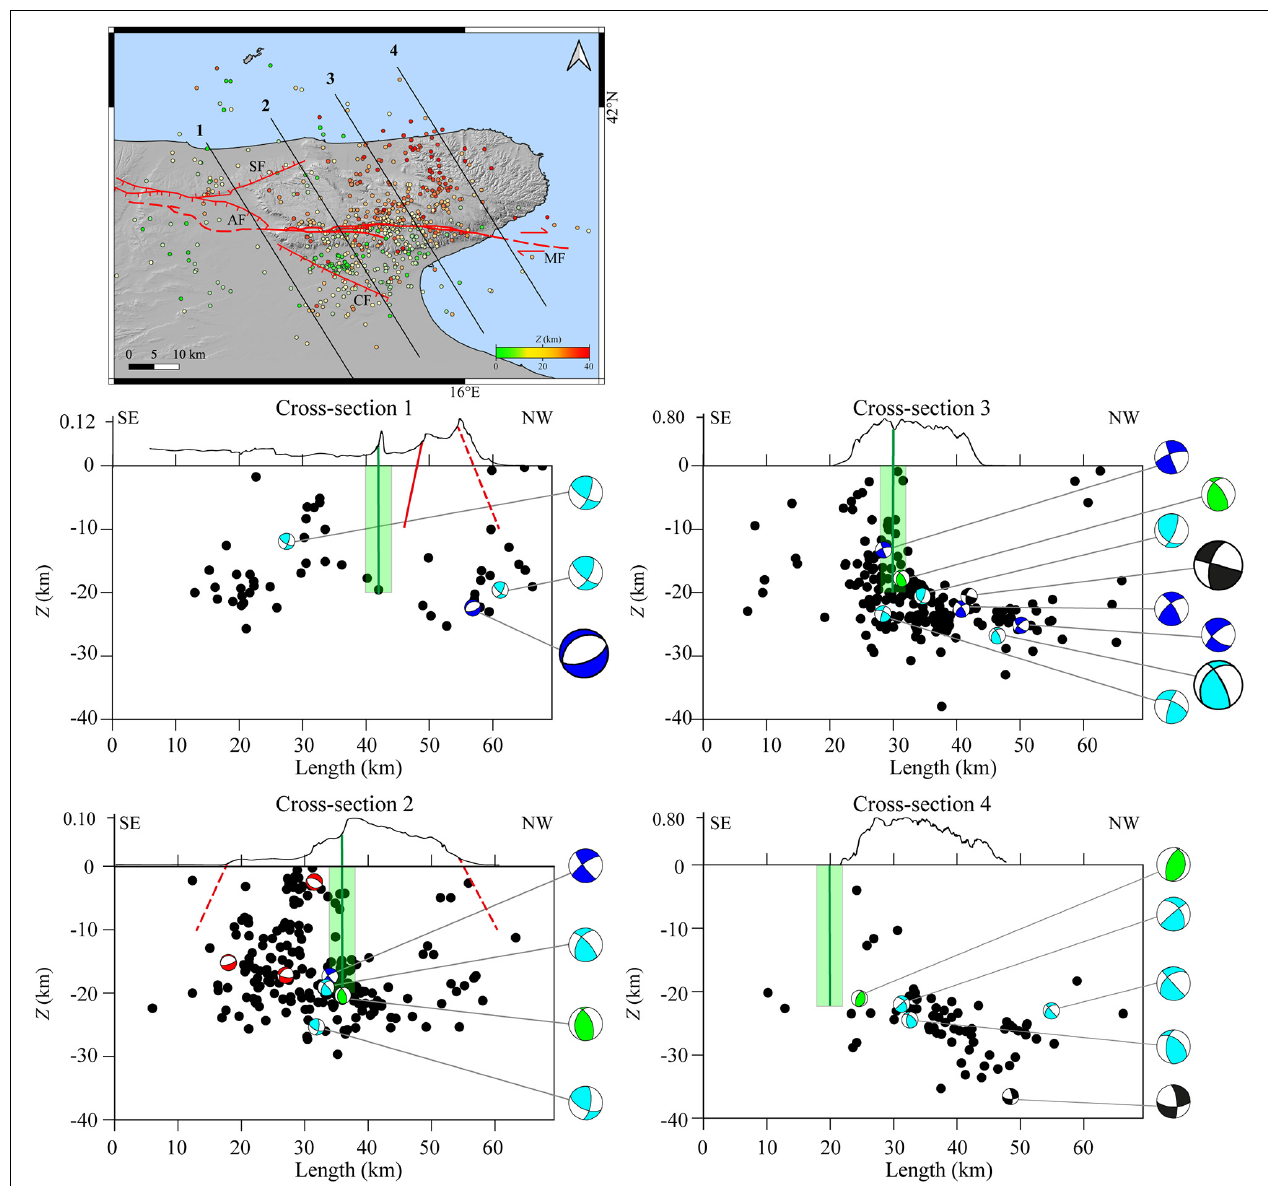
FIGURE 10 | The same as Figure 7 for SE-NW cross-sections. All cross-sections have 69 km length and 8 km semi-width per side.